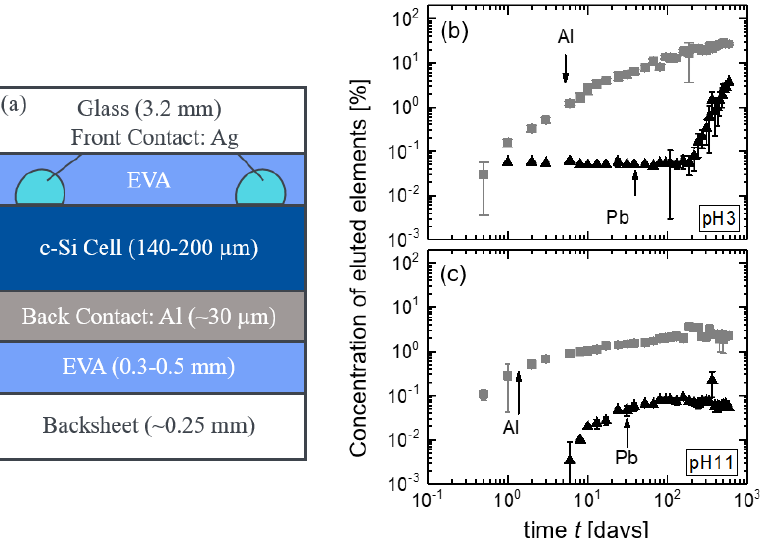
Figure 9. ( a ) Schematic structure of a typical c-Si module (not drawn to scale) and ( b ) time-dependent leaching results of Al and Pb from c-Si module pieces in acidic aqueous solutions with pH 3 and ( c ) in solutions with pH 11. In leaching solutions with pH 7, the concentrations of Al and Pb are below the detection